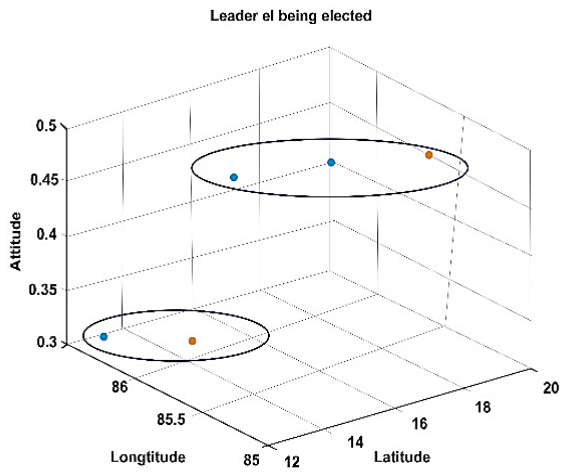
Figure 10. Representation of clustering of five drones as two clusters. Table 2. Drone Parameters considered for implementation.